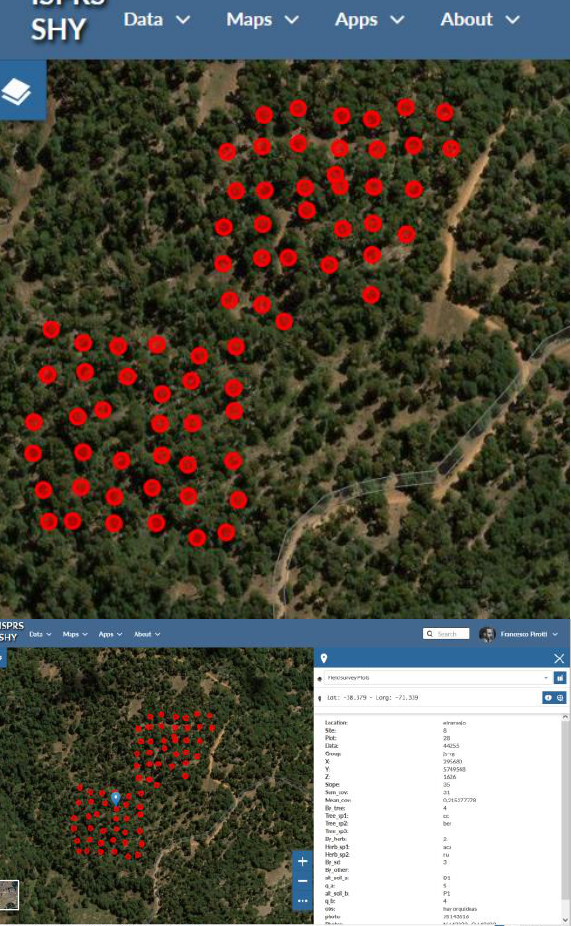
Figure 6. Plots from CONAF-financed project with relative data form ground samples.